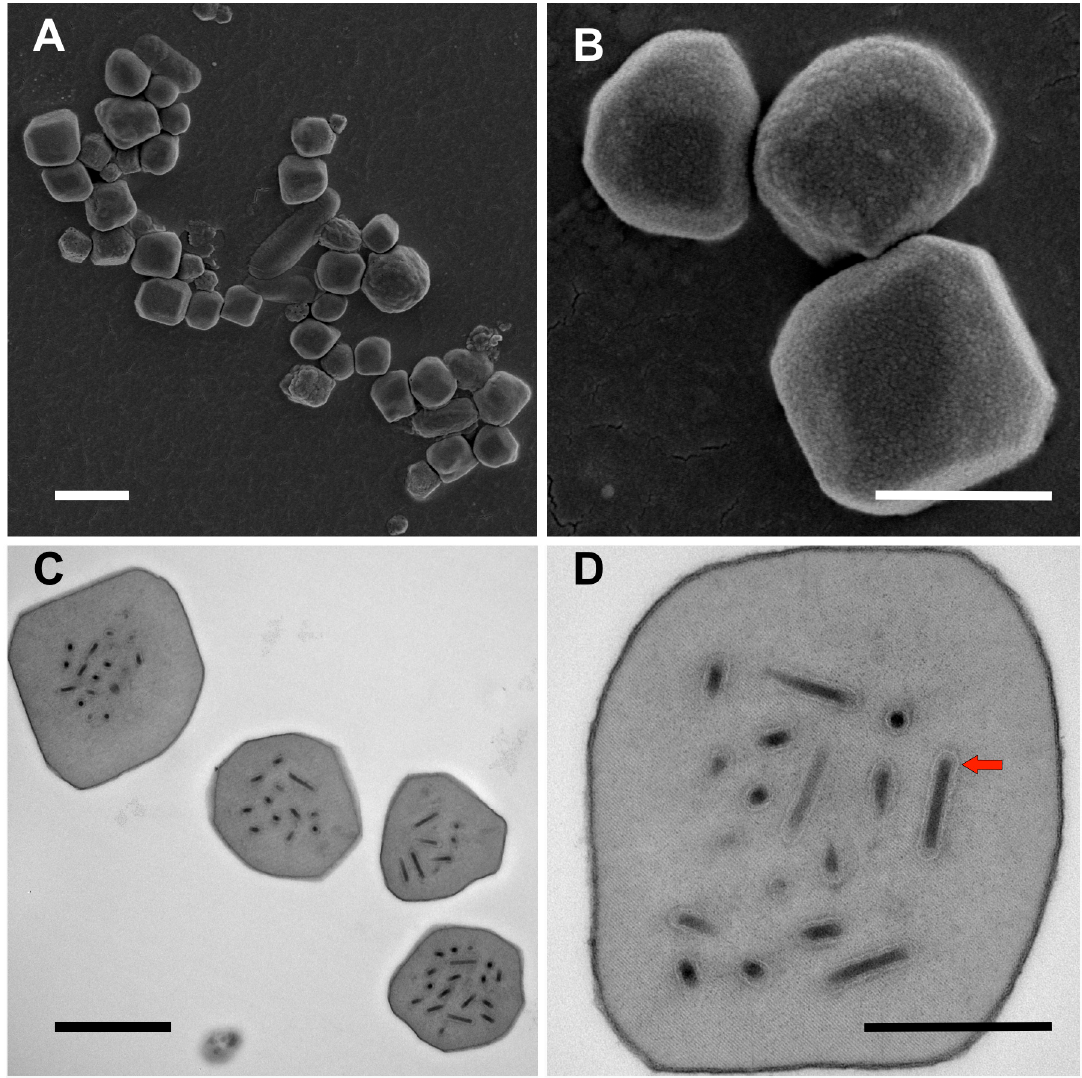
Figure 1. Occlusion bodies (OBs) of alphabaculovirus OpbuNPV-MA (Massachusetts isolate of OpbuNPV). ( A , B ) Scanning electron micrographs of OpbuNPV-MA OBs. ( C , D ) Transmission electron micrographs of OpbuNPV-MA OBs. The red arrow in ( D ) denotes the envelope surrounding the rod-shaped nucleocapsid of a virion. Scale bars: ( A ) 2 μ m; ( B , C ) 1 μ m; ( D ) 500 nm.